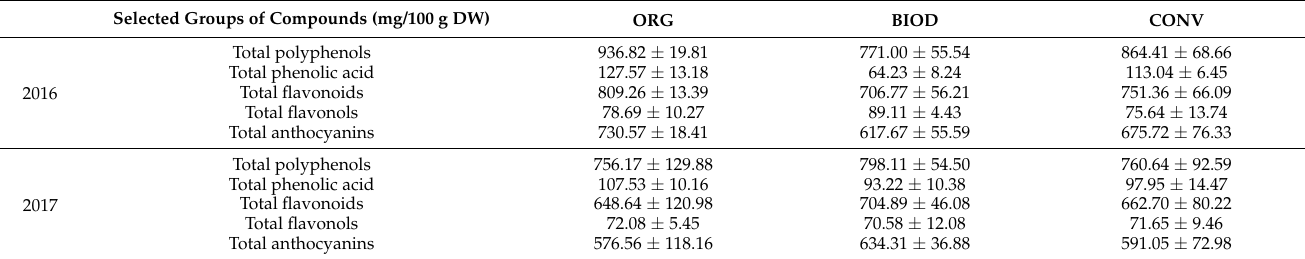
Table 1. Content of phenolic compounds from different chemical group in experimental blueberry extracts. Mean values ± standard